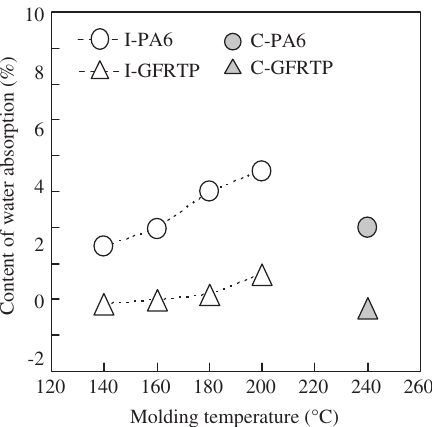
Figure 8 Water absorption of I-PA6 and C-PA6 and of I-GFRTP and C-GFRTP.